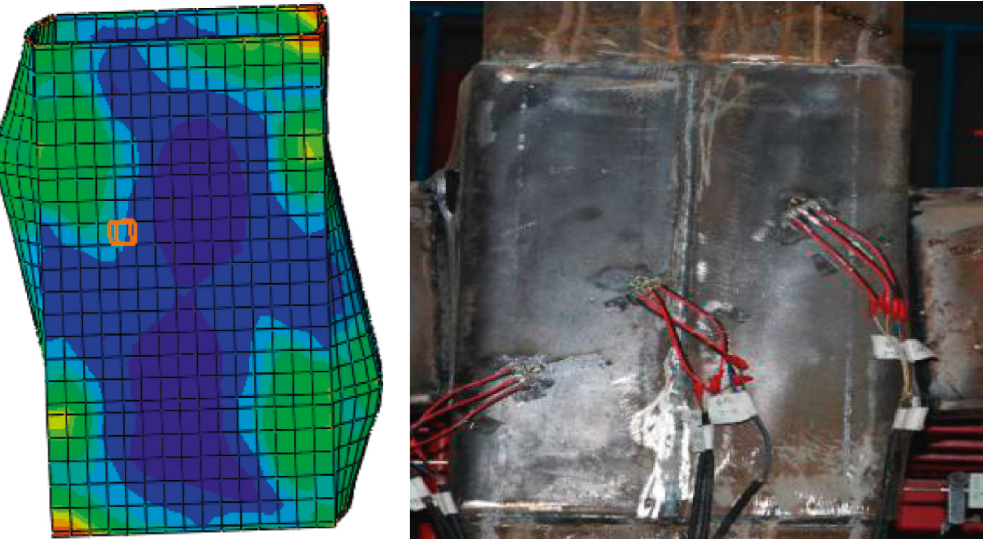
Figure 8: Failure mode.